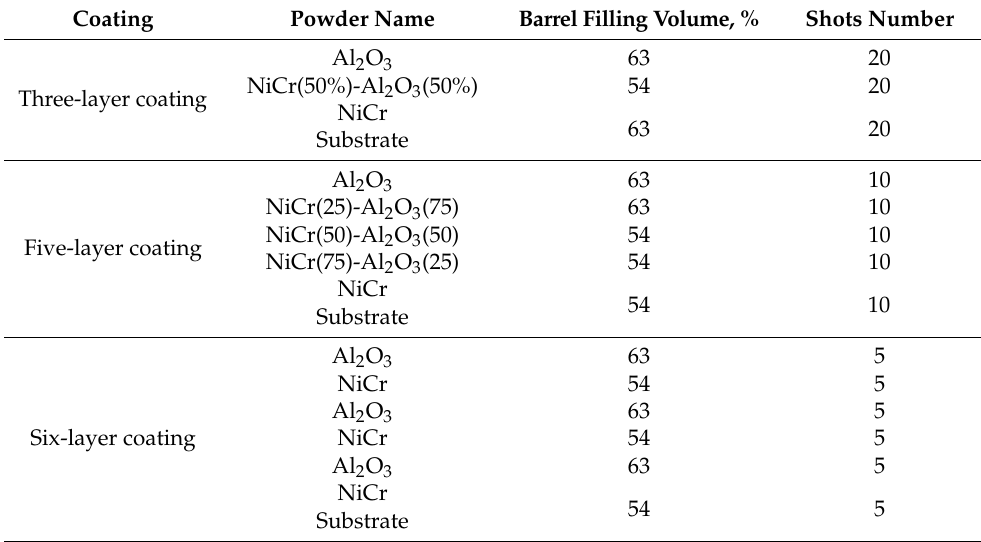
Table 1. The technological parameters for obtaining multilayer gradient coatings based on NiCr/NiCr-Al 2 O 3 /Al 2 O 3 . Coating Powder Name Barrel Filling Volume, % Shots Number Al 2 O Three-layer coating